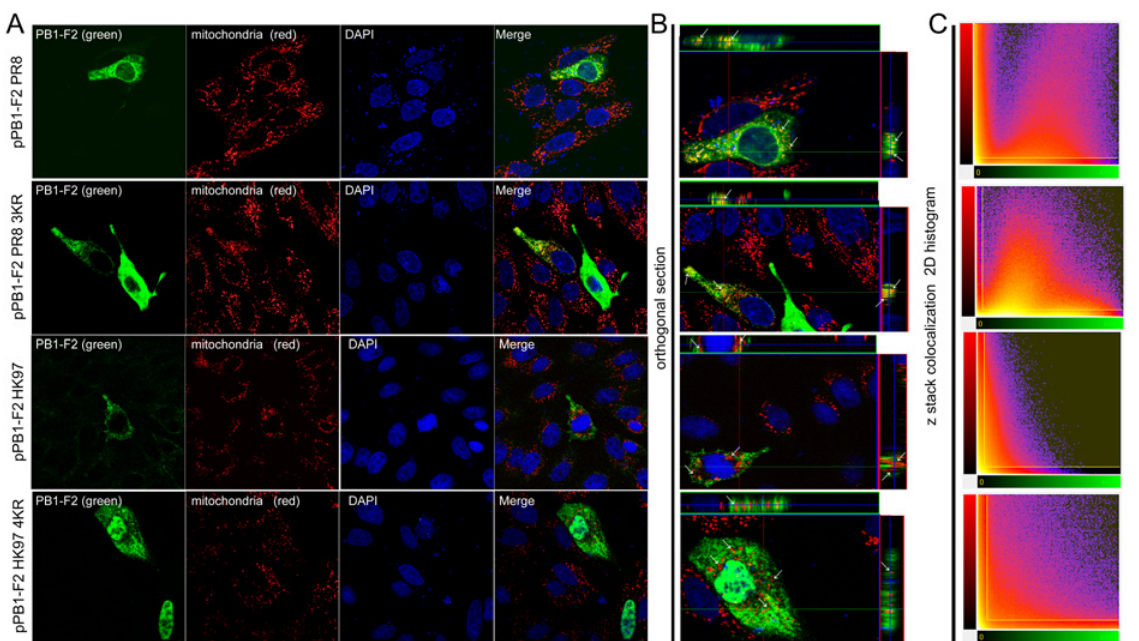
Fig 4. Subcellular localization of PR8- and HK97-derived PB1-F2 wt and the C-terminal K residue cluster mutants. MDCK cells were transfected transiently with the respective PB1-F2 expressing plasmid (1 μ g pPB1-F2 PR8/pPB1-F2 PR8 3KR/pPB1-F2 HK97/ pPB1-F2 HK97 4KR). At 24 hr p.t., the cells were stained with Mitotracker RedCMXRos according to the manufacturer ’ s instructions (Life Technologies), fixed and stained for the presence of PB1-F2 variants (A). mAb AG55, specific to N-terminal region of the PB1-F2, and the FITC-conjugated secondary antibody were used to stain PB1-F2 (green, left column). Mitotracker RedCMXRos was used to stain mitochondria (red, second left column). Merge of PB1-F2 and mitochondrial signals (yellow, right column) showing clearly visible colocalization in PB1-F2 PR8 and PB1-F2 PR8 3KR-positive cells. The nuclei were stained with DAPI. (B) Orthogonal section reconstruction suggests the colocalization of the PB1-F2 with mitochondria signal throughout the entire cytoplasm for PR8-derived PB1-F2 and PB1-F2 PR8 3KR, but not for PB1-F2 HK97 and PB1-F2 HK97 4KR. The images were acquired at the same exposure, pinhole and optical slice conditions. (C) Image analysis software (Bitplane Imaris) was used to generate 2D histograms of the PB1-F2 (green) and mitochondria (red) signal intensities for volume pixels (voxels) and calculating Pearson ’ s coefficient in colocalized volume.